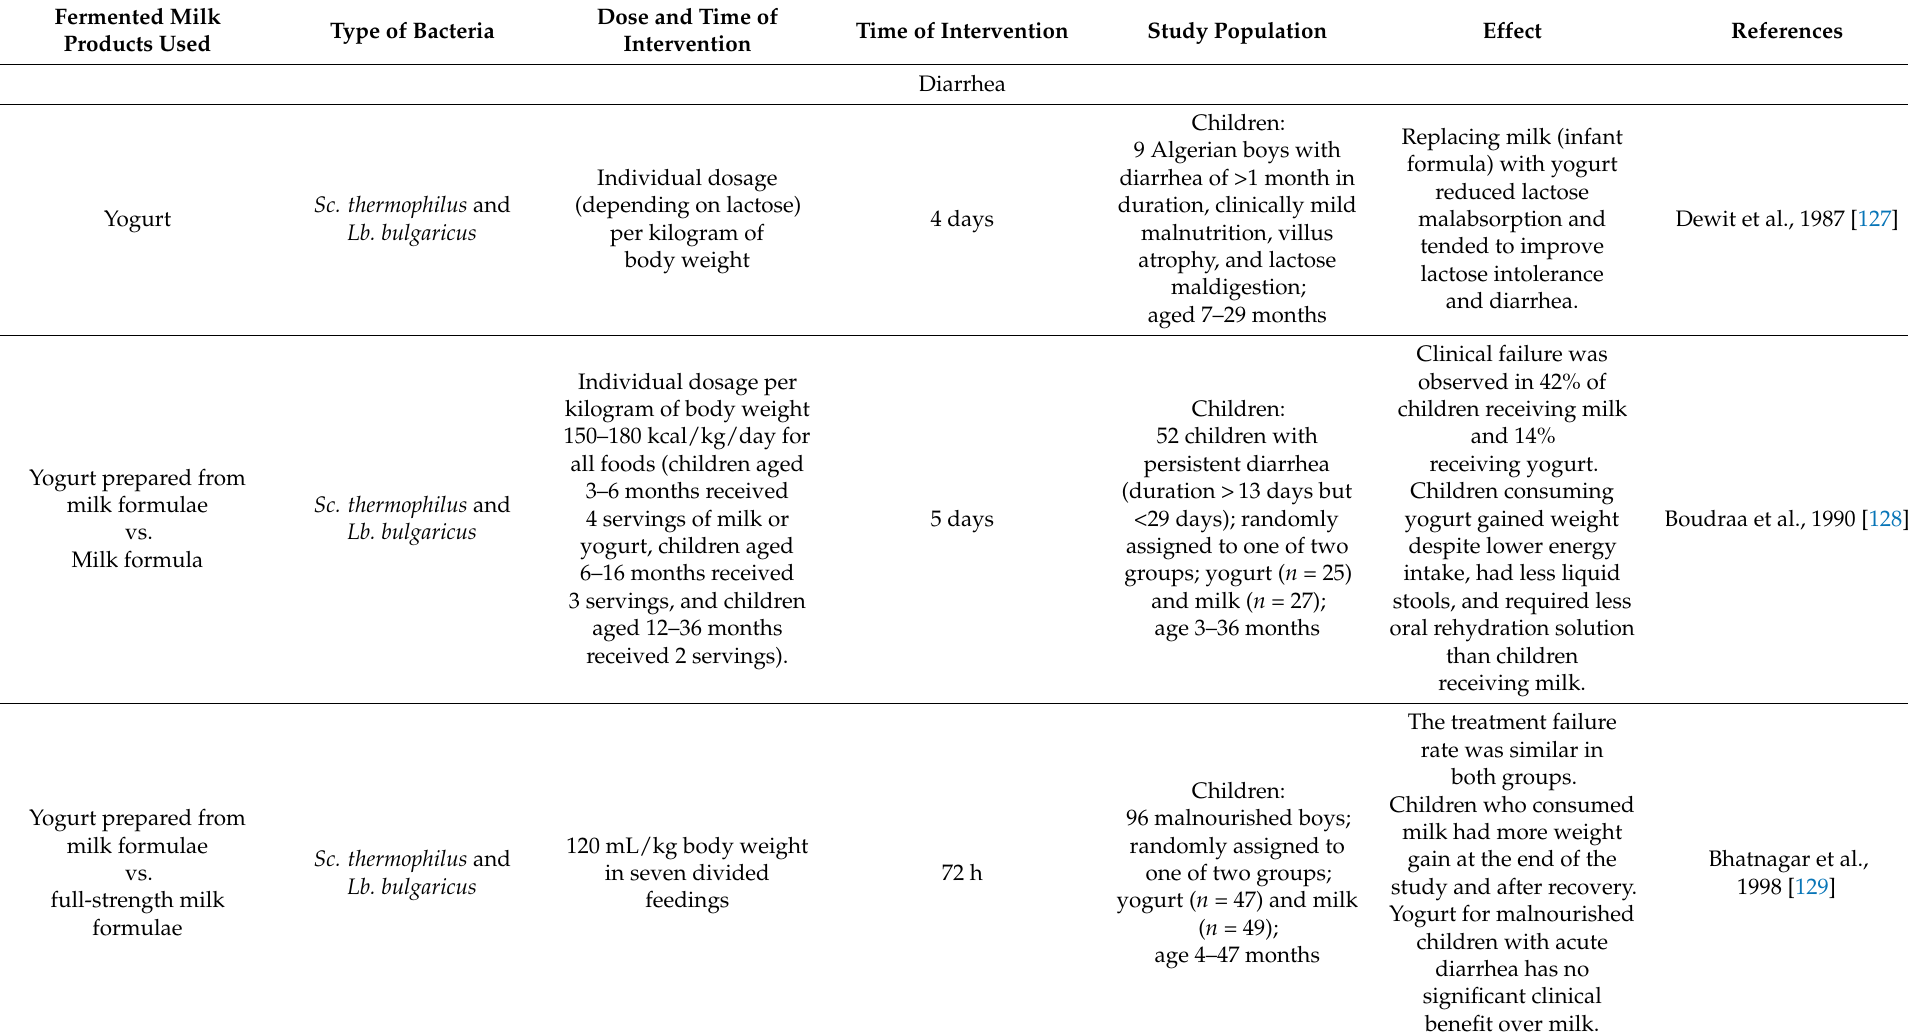
Table 4. The effect of fermented milk products on the microbiota composition in humans with gastrointestinal